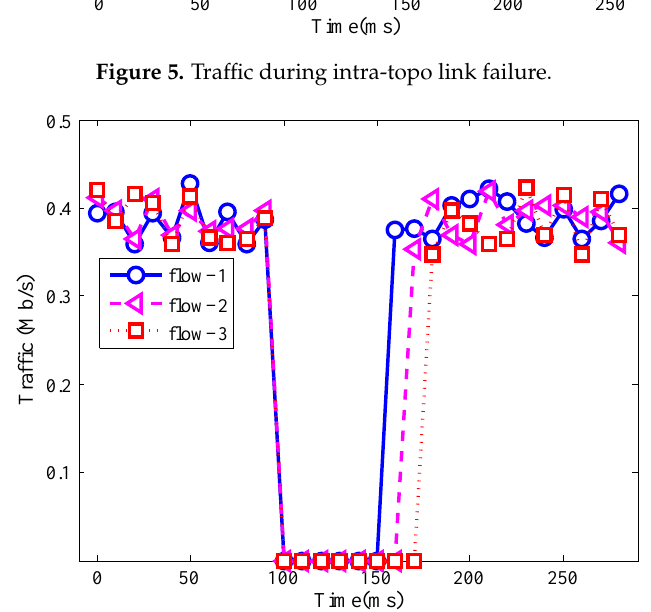
Figure 6. Traffic during switch